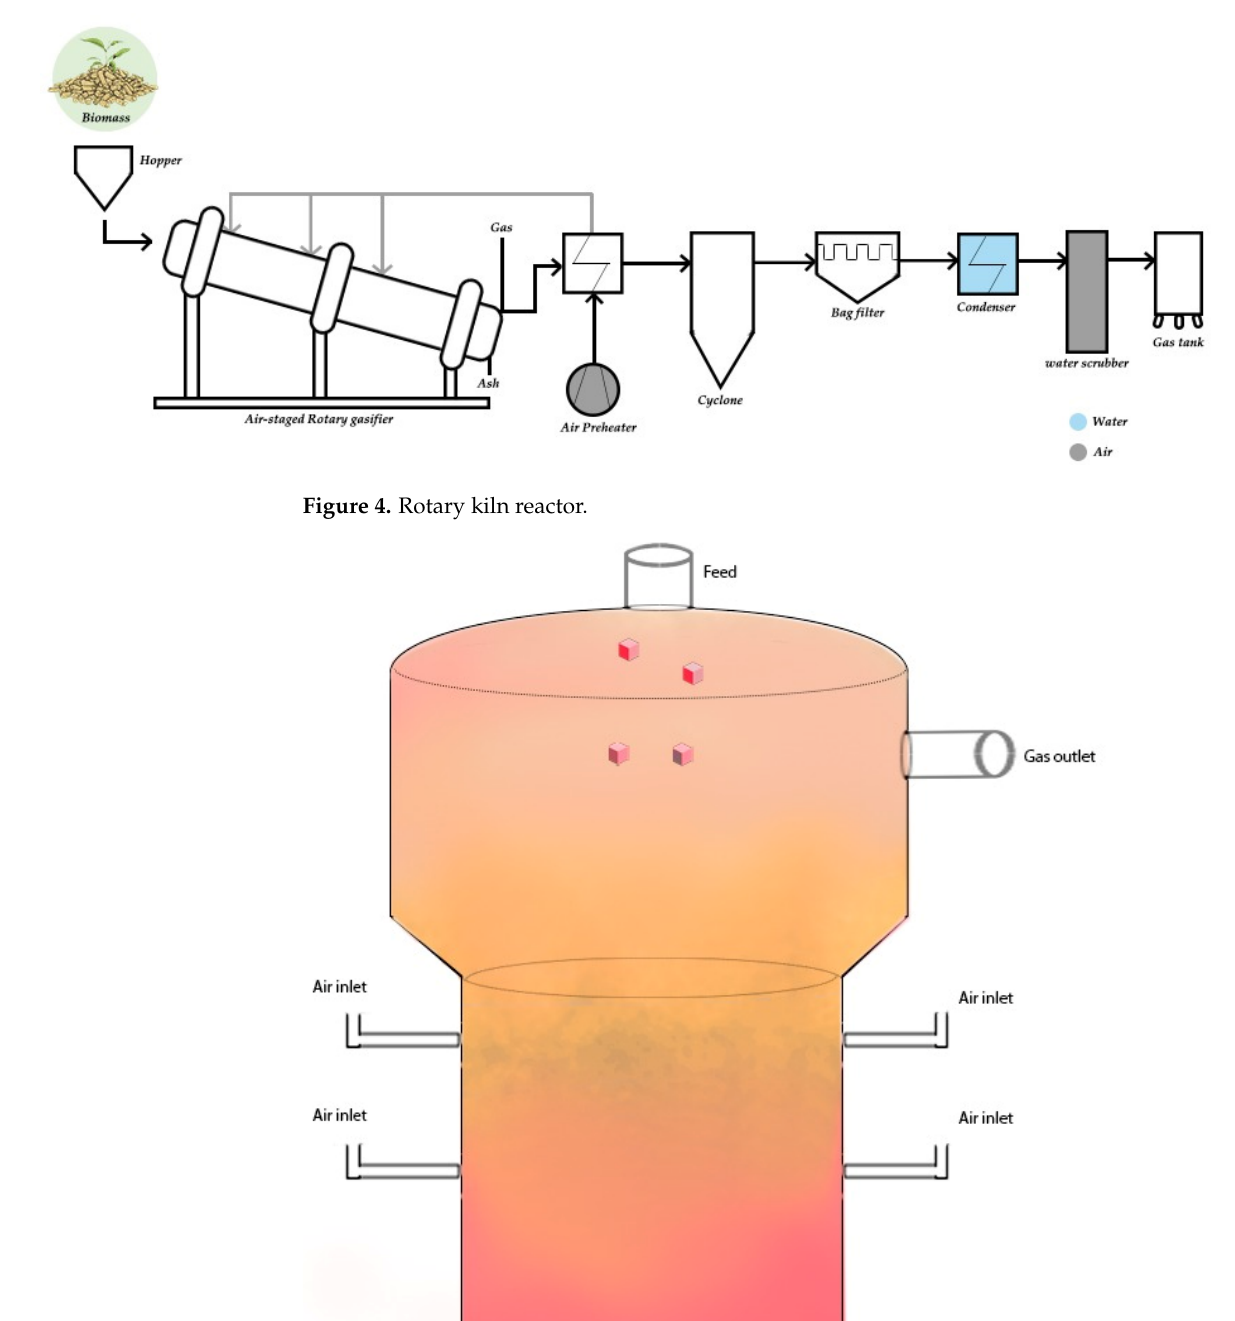
Figure 3. Entrained flow gasifier.